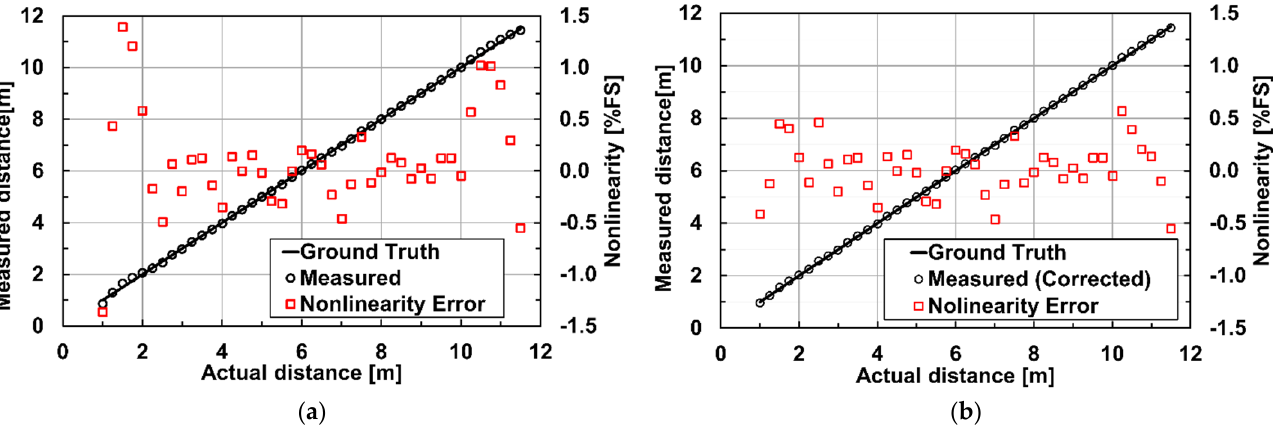
Figure 9. Measurement distance linearity and nonlinearity errors under background light conditions: ( a ) measured distance and non-linearity error (without error corrections); ( b ) measured distance and non-linearity error (with error corrections).